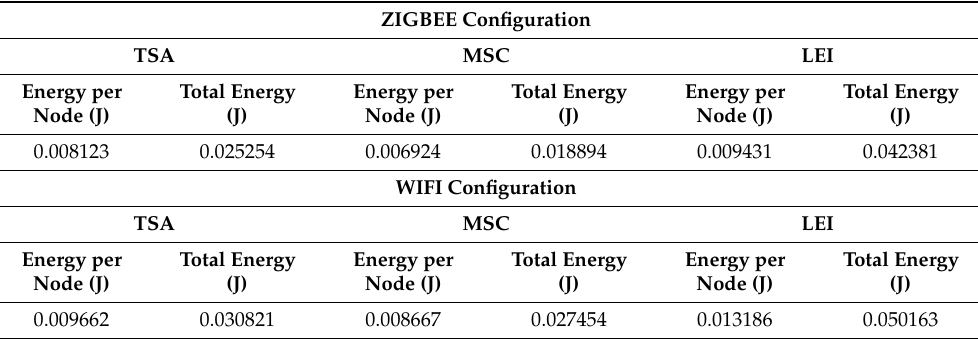
Table 8. Energy behavior per each studied algorithm under MPH protocol.